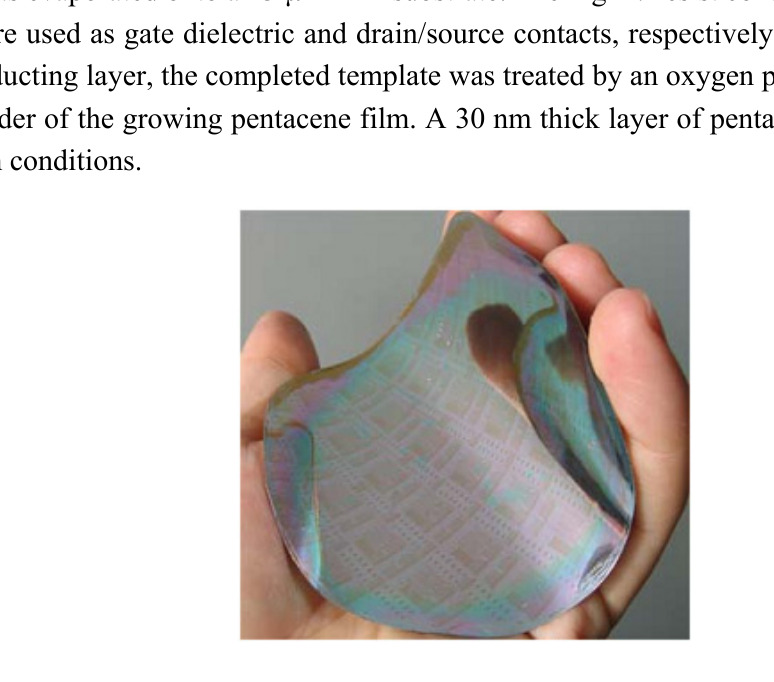
Figure 23. OFET on a PET substrate using a high- k dielectric. Reprinted from [47], with permission from John Wiley and Sons.